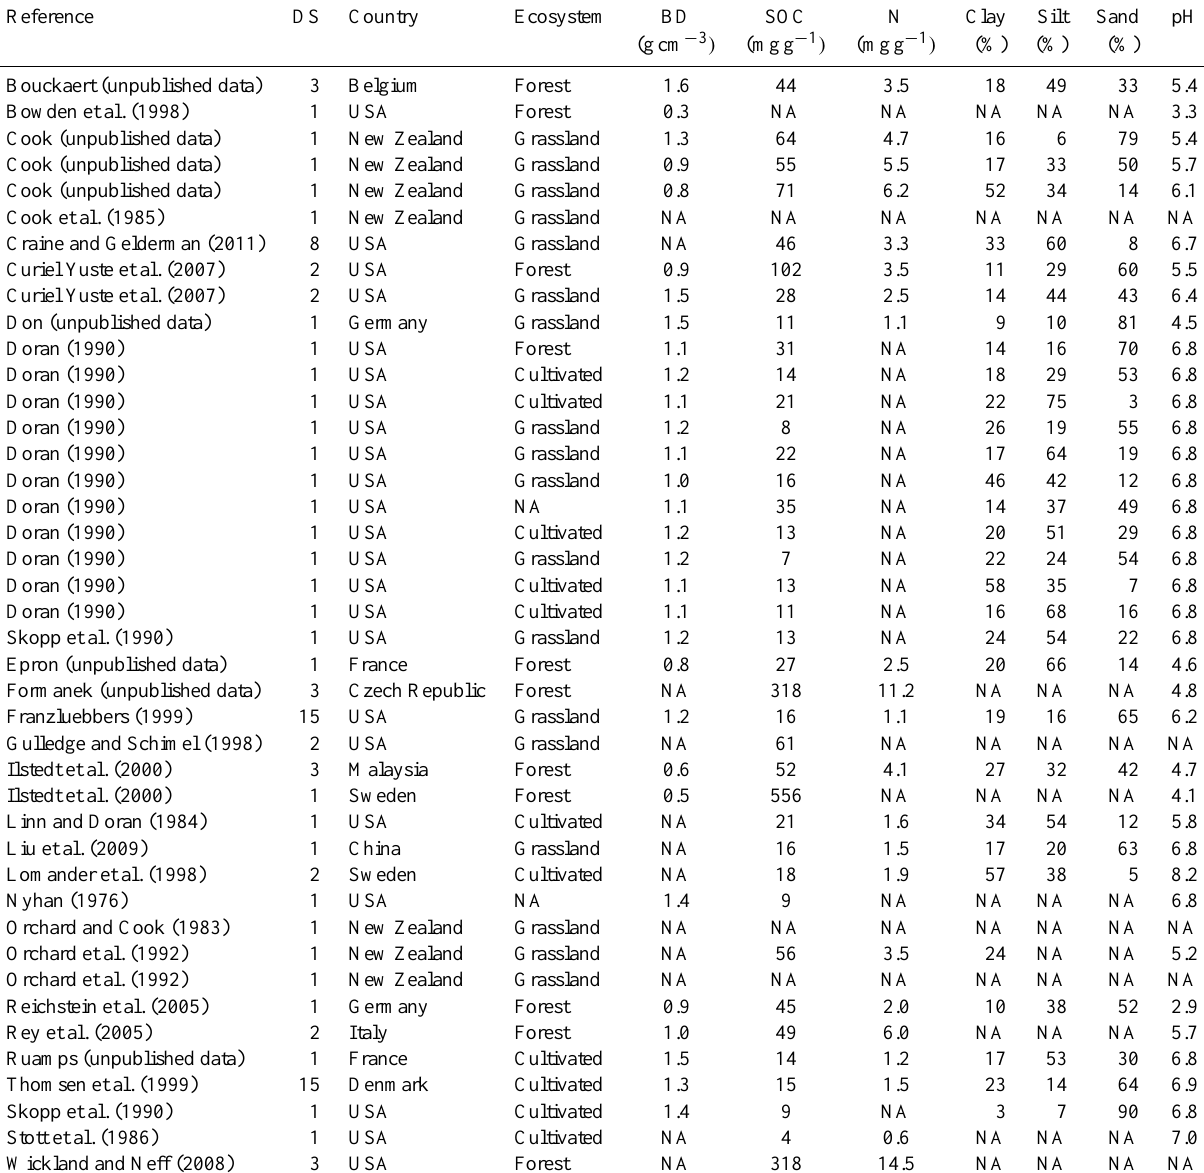
Table 1. Description of the data used in the analysis. Each line represents a specific site or location. DS is number of data sets, representing different soil types related to each site. Site averages of soil properties used in the analysis are shown. BD=bulk density, SOC=soil organic carbon, N=soil